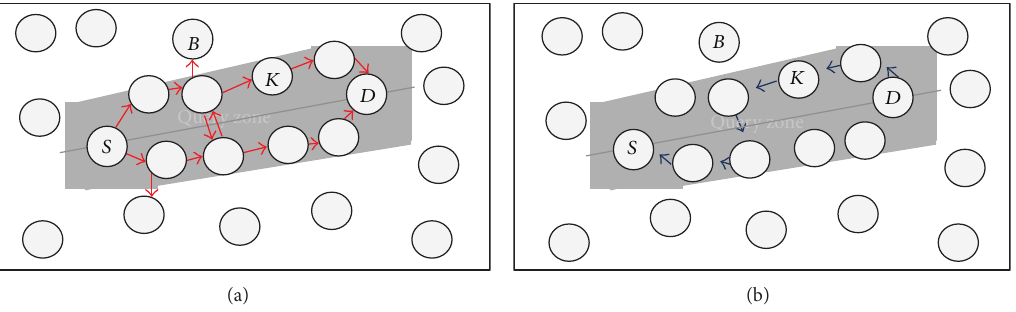
Figure 1: EPR routing mechanism: (a) query broadcasting and (b) data